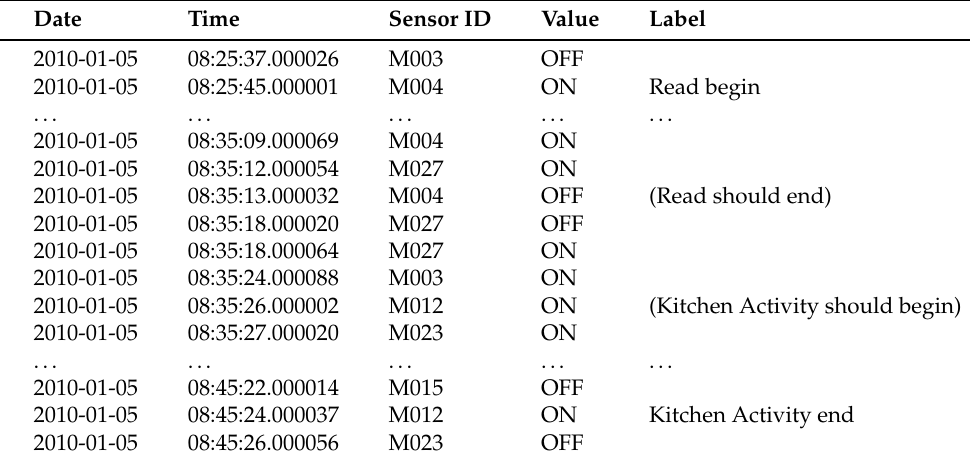
Table 4. CASAS [75] Milan dataset